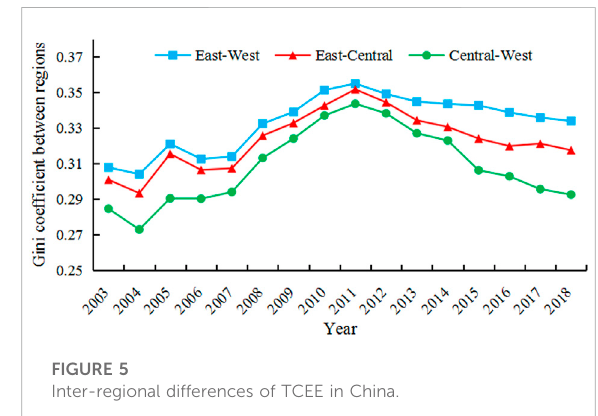
FIGURE 5 Inter-regional differences of TCEE in